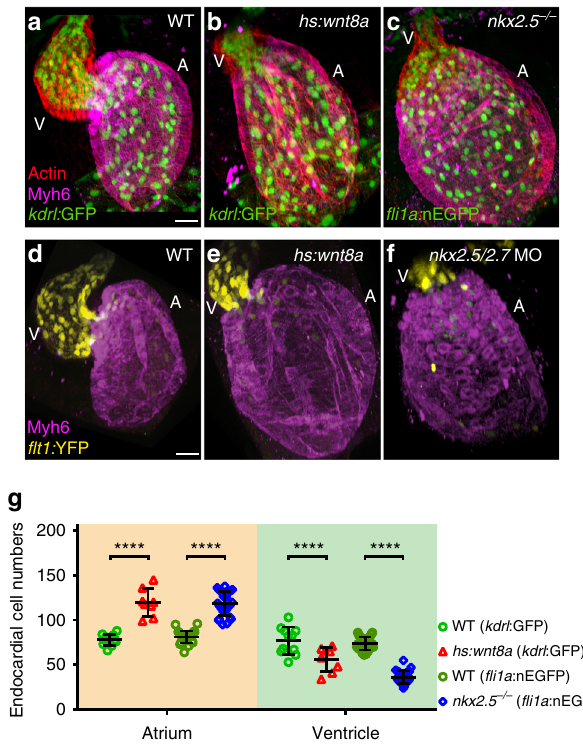
Fig. 1 Overexpression of Wnt8a or loss of Nkx2.5 causes a shift in endocardial chamber proportions. a – c Reconstruction of confocal z-stacks show the endothelial-speci fi c transgenic reporter lines Tg(kdrl:EGFP) s843 or Tg( fl i1a:nEGFP) y7 (green), Phalloidin 568-stained Actin (red) and anti-Myh6 labeling of the myocardial atrial chamber (magenta). Compared to ( a ) WT, ( b ) overexpression of Wnt8a, or ( c ) the nkx2 . 5 vu179 mutation, causes a relative shift of endocardial chamber dimensions. d – f Reconstructions of confocal z-stacks shows that the arterial endothelial transgene Tg( fl t1:YFP) hu4624 marks the ventricular chamber whereas the myocardial atrial marker anti-Myh6 labels the atrial chamber. Compared to ( d ) WT, ( e ) overexpression of Wnt8a, or ( f ) loss of Nkx2.5/Nkx2.7 results in relative shifts of chamber dimensions as indicated by the ventricular-speci fi c expression of Tg( fl t1:YFP) hu4624 within the endocardium. A, atrium; V, ventricle. Scale bars, 30 μ m. g Quanti fi cations of endocardial cell numbers in WT ( kdrl :GFP n = 11 hearts, fl i1a :nEGFP n = 27 hearts), Tg(hsp70l:wnt8a- GFP) w34 ( n = 8 hearts), or nkx2 . 5 vu179 mutants ( n = 27 hearts) reveal that atrial endocardial cell numbers are signi fi cantly increased and ventricular endocardial cell numbers are signi fi cantly reduced compared to WT.